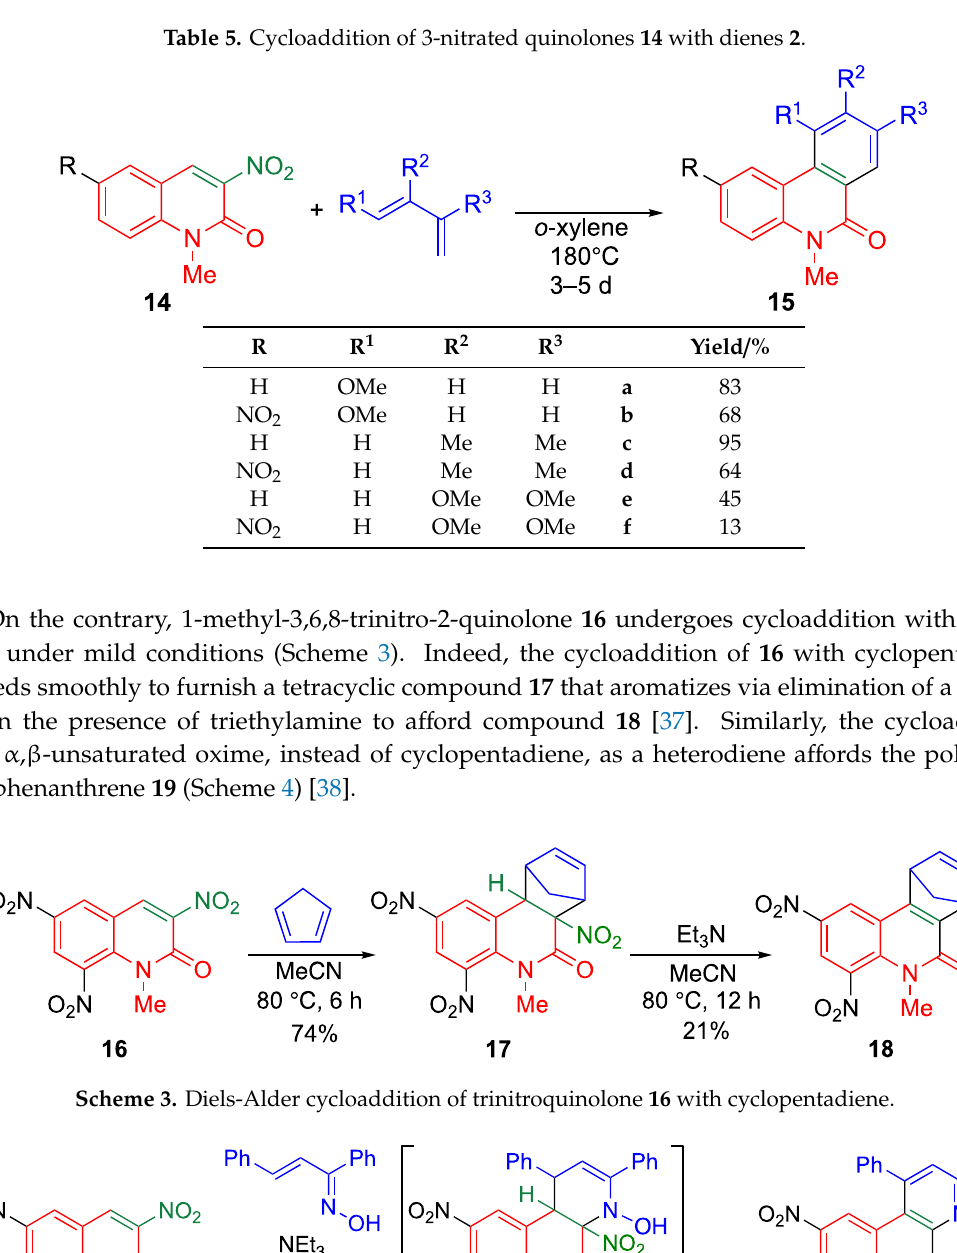
Scheme 4. Cycloaddition of 16 with α , β -unsaturated oxime.